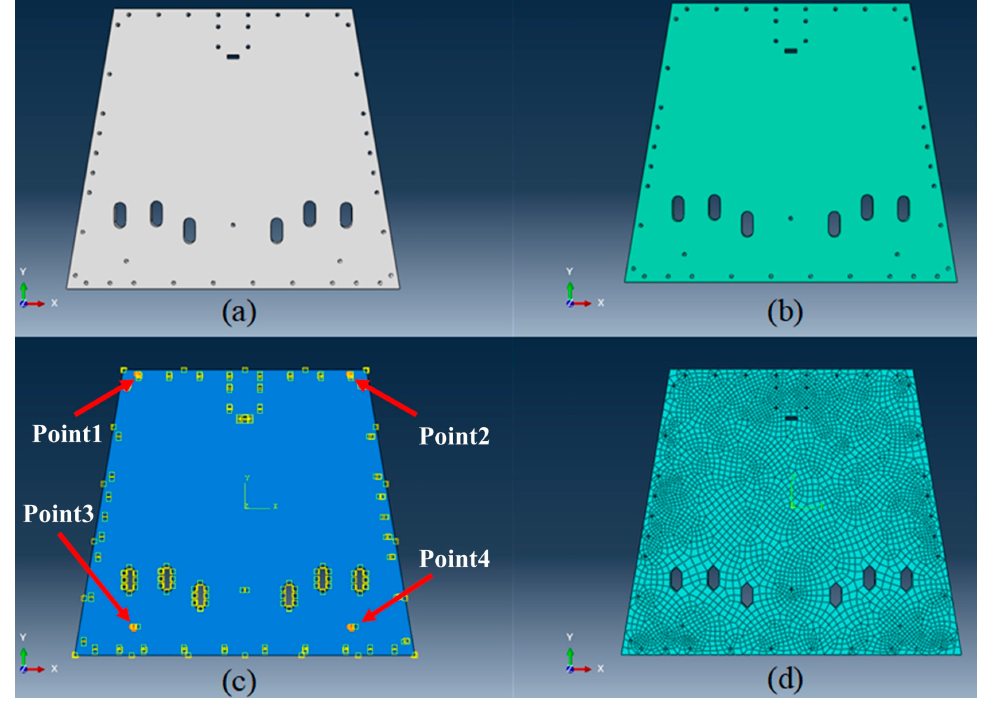
Figure 10. Finite element model of honeycomb panel. ( a ) geometric model ( b ) input material parameters ( c ) fixed points ( d ) divide into hexahedral mesh